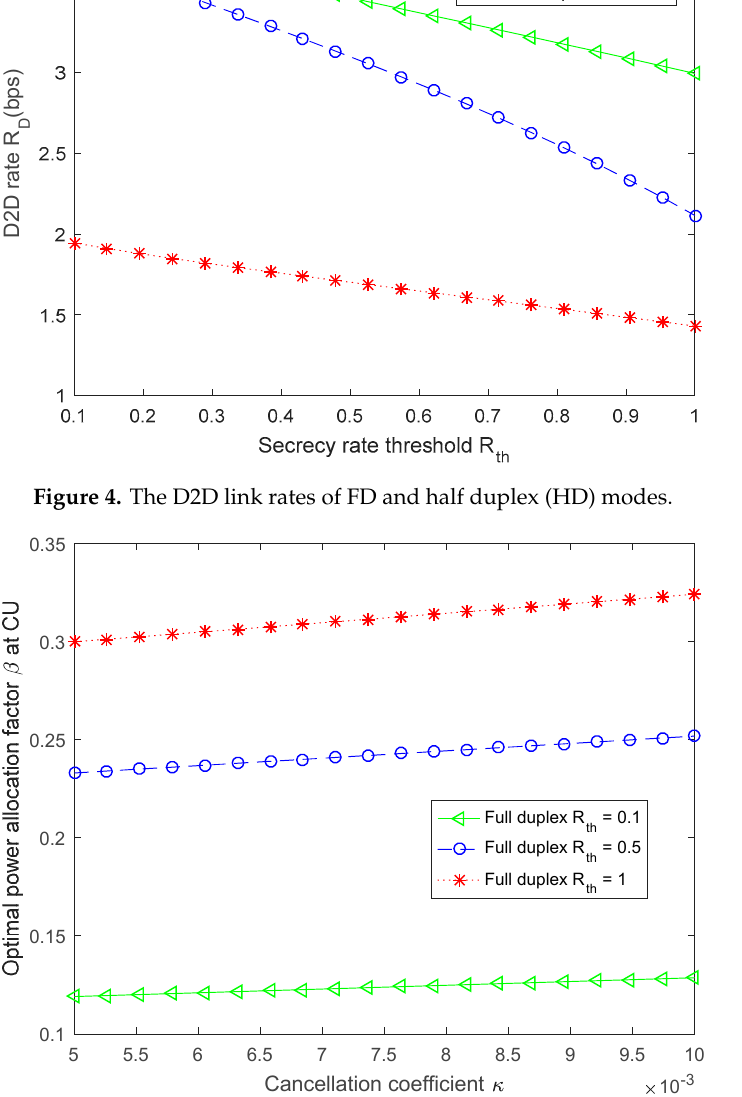
Figure 4. The D2D link rates of FD and half duplex (HD) modes.